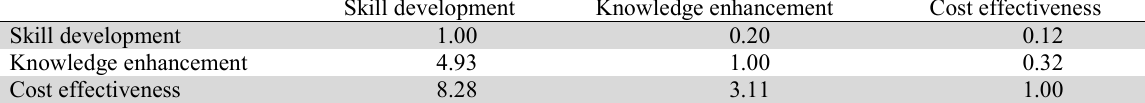
Comparison matrix for comparing the sub-factors of “benefits of MOOCs” Skill development Knowledge enhancement Cost effectiveness Skill development